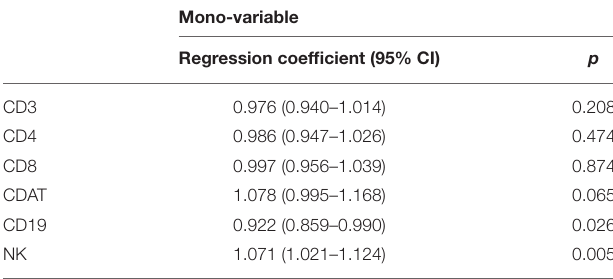
TABLE 2 | Logistic regression analysis for the peripheral immunological profile to predict pregnancy (implantation success) by control group (Non-IVIG treatment, n =